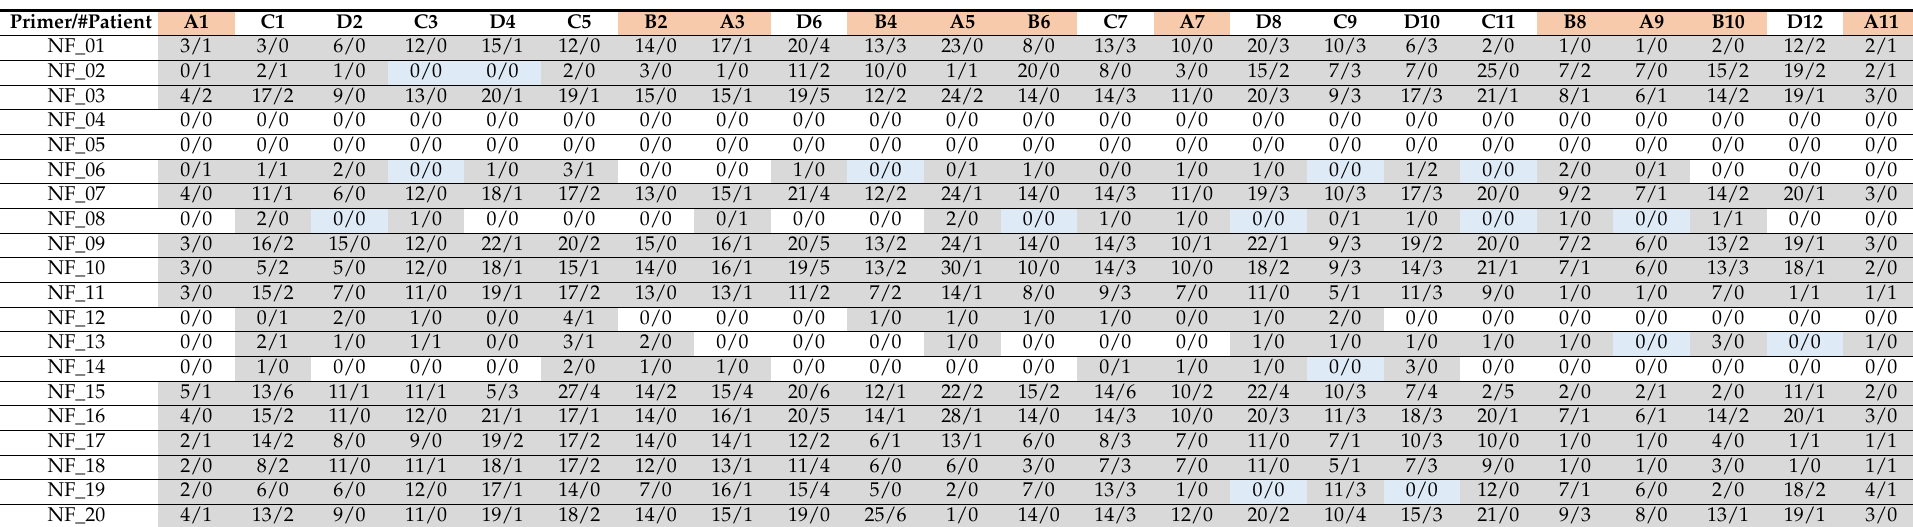
Table 5. Heterozygosity mapping of the NF1